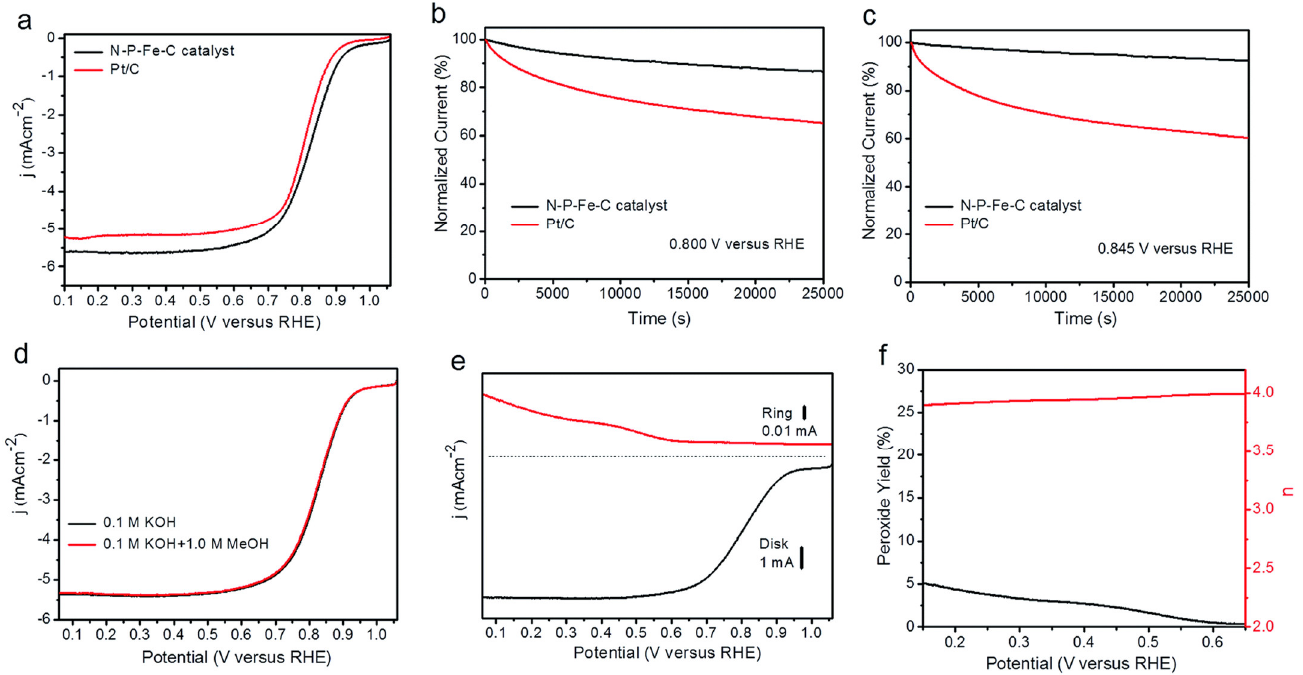
Figure 9. ( a ) Polarization curves for N, P, Fe tri-doped biochar (N-P-Fe-C) and Pt/C obtained at 1600 rpm in 0.1 M KOH; ( b ) chronoamperograms obtained at E = 0.800 V vs. RHE or ( c ) E = 0.845 V vs. RHE; ( d ) polarization curves for N-P-Fe-C catalyst in absence/presence of methanol; ( e ) RRDE voltammograms; ( f ) peroxide yield and number of electrons transferred per O 2 molecule for N-P-Fe-C. Reproduced from [176] with permission from the Royal Society of